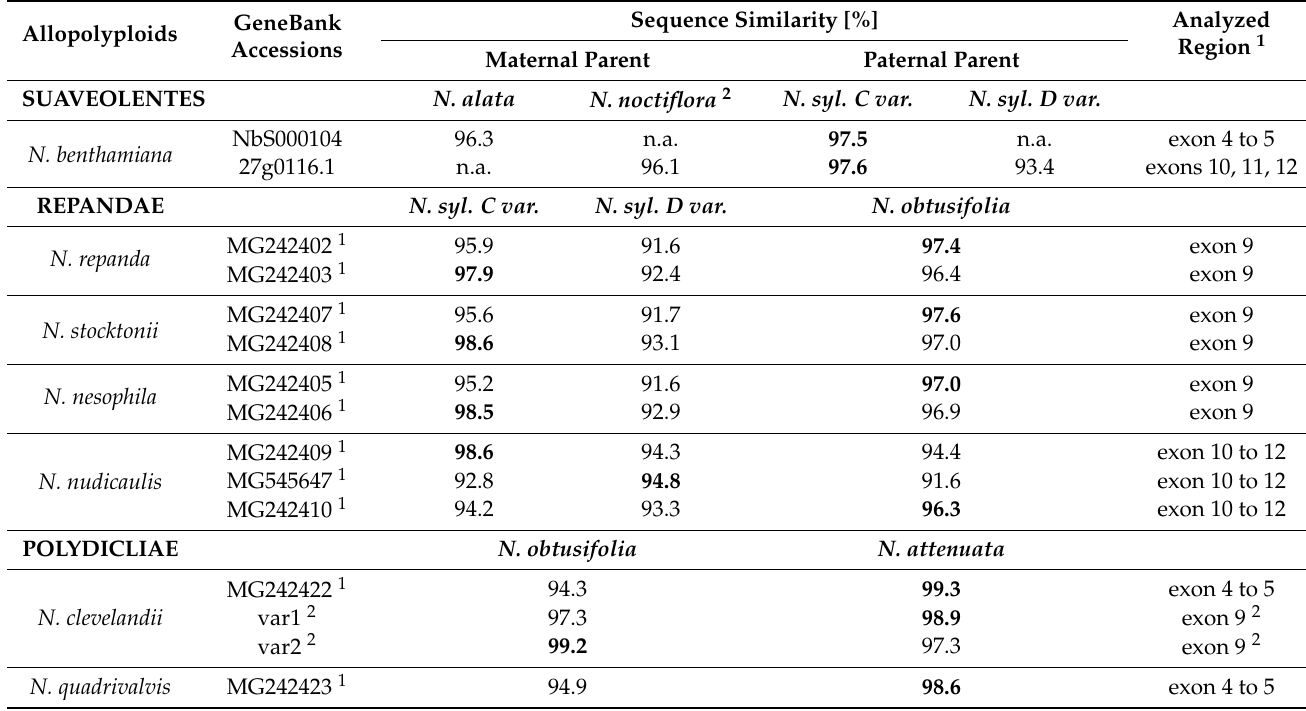
Table 1. Origin of telomerase reverse transcriptase ( TERT ) variants in polyploid Nicotiana species determined by sequence similarity with representative progenitor